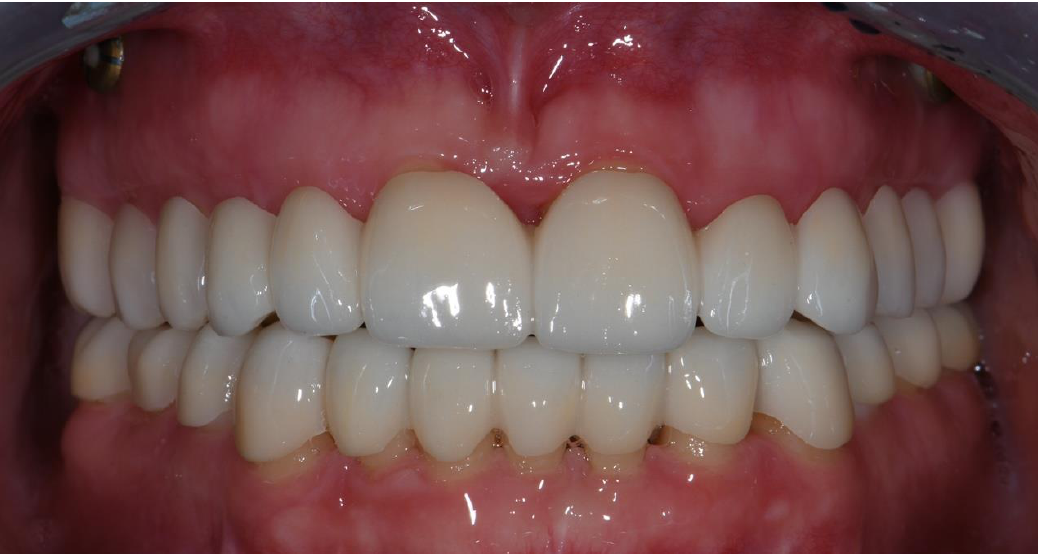
Figure 15. Case 4—Intraoral view of the patient wearing DEFS.